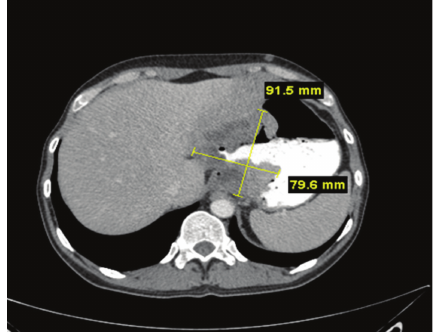
Figure 3: A 9.15cm × 7.96 cm soft tissue mass within the cardia of the stomach involving the gastroesophageal junction and along the lesser curvature. Note the localized invasion of the tumor into the liver